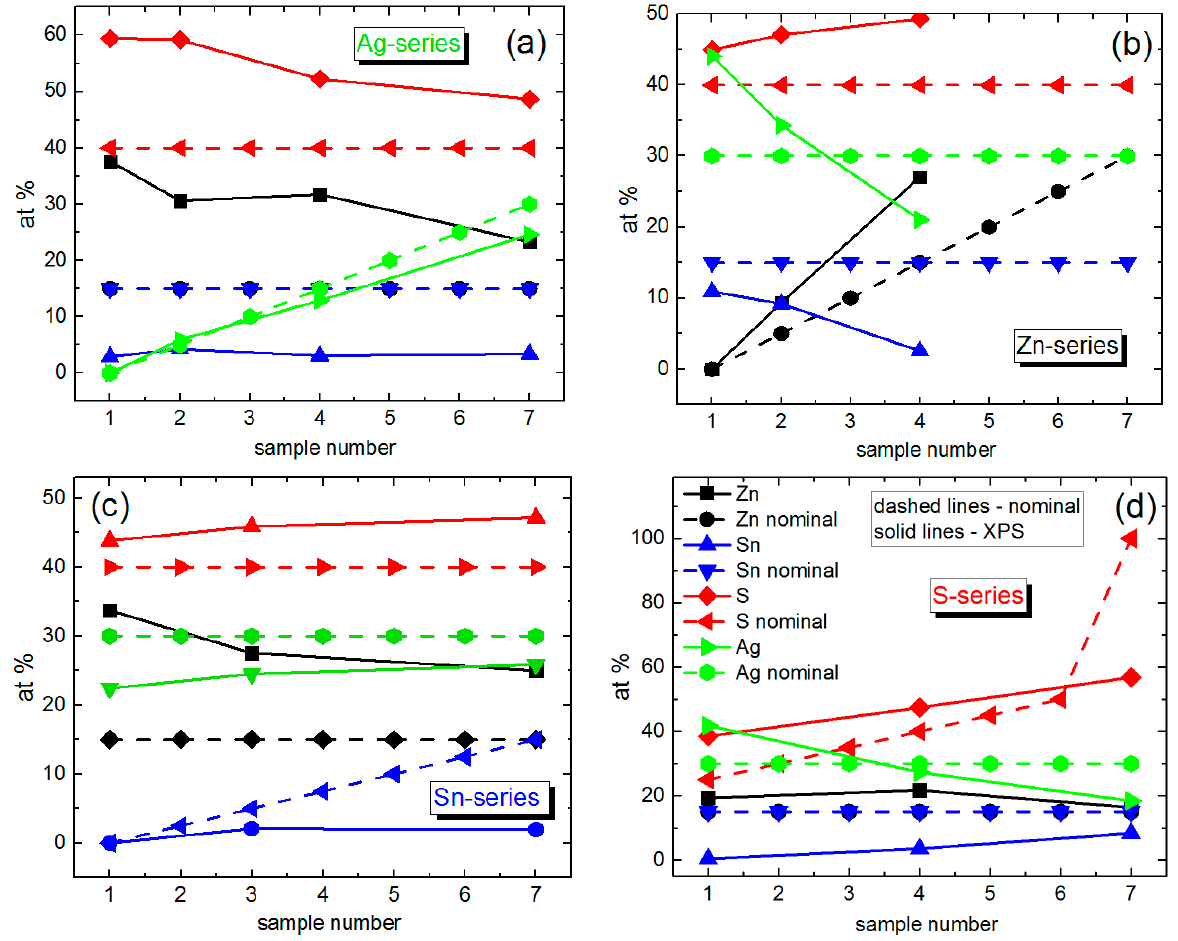
Figure 5. Elemental composition of different series of AZTS NCs with variation of different components: Ag ( a ), Zn ( b ), Sn ( c ), and S ( d ).